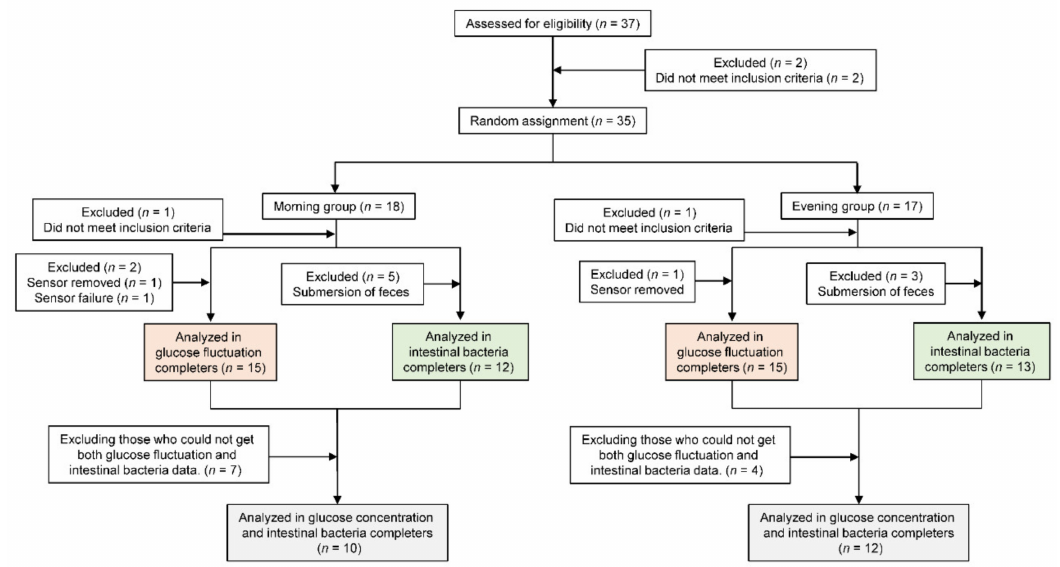
Figure 1. Consolidated Standards of Reporting Trials flow